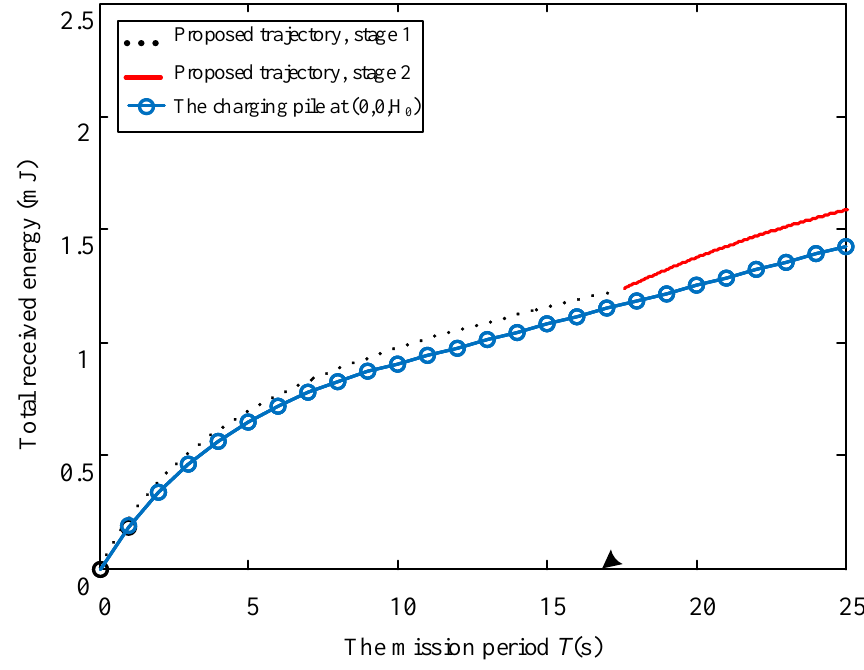
Figure 7. The relationship between total received energy and mission period T with V =